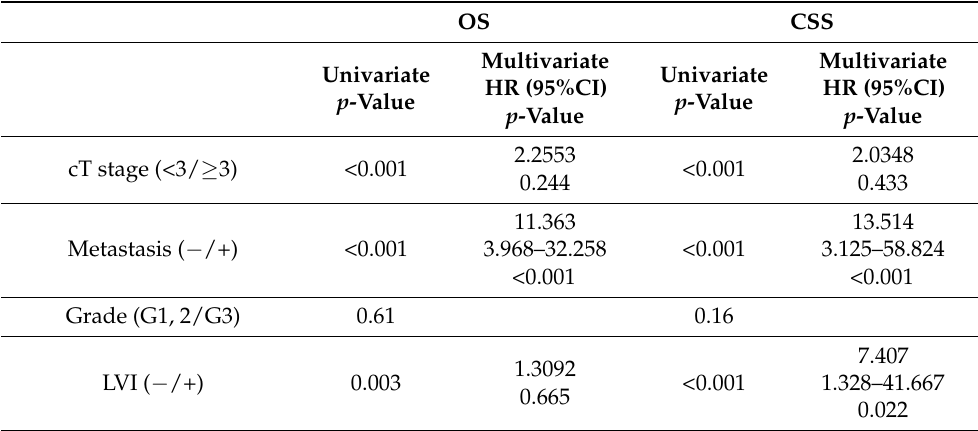
Table 2. Uni- and multivariate analyses of clinicopathological variables for OS and CSS after first